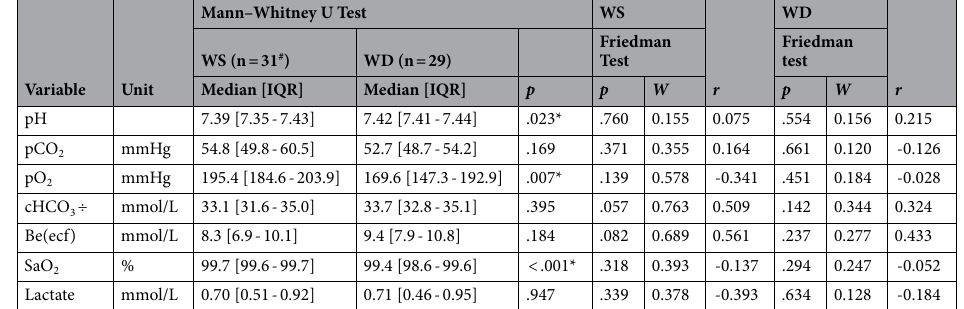
Table 3. Arterial blood gas analysis from animal experiments. Summary for two animal groups ÷ pairs with similar weights ( WS ) and pairs with different weights ( WD ). Mann ‒ Whitney U test—between the groups for all blood samples. Friedman Test—analysis of blood samples across time by the ANOVA Friedman test for each group separately. pH, The activity of hydrogen ions; pCO 2 , Carbon dioxide partial pressure; pO 2 , Oxygen partial pressure; cHCO 3÷ , Bicarbonate concentration; Be(ecf), Base excess in the extracellular fluid; SaO 2 , Oxygen saturation of hemoglobin; lactate, Lactate level; IQR, Interquartile range; W , Kendal’s coefficient of concordance; r , Spearman’s rank correlation coefficient. * p < 0.05 considered statistically significant. # n = 30 for